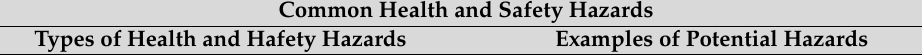
Table 1. Summary of health and safety risks related with ASM.